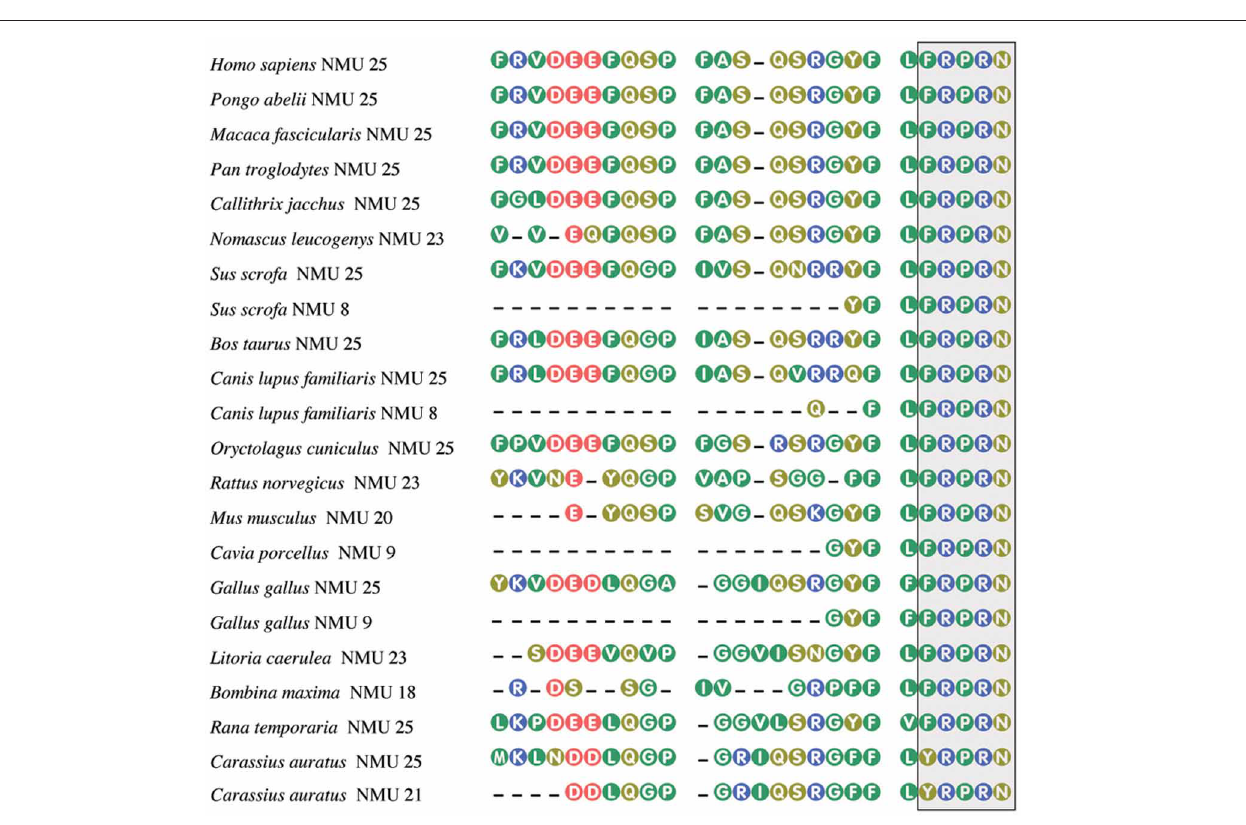
FIGURE 1 | Amino acid sequences of neuromedin U from some mammalian, avian, piscine, and amphibian species. The box, highlighting the C-terminal pentapeptide, shows conservation of this sequence in vertebrates, except of goldfish. From Mitchell et al. (2009a), modified. Amino acid sequences were acquired from NCBI. Numbers after NMU denote peptide length.